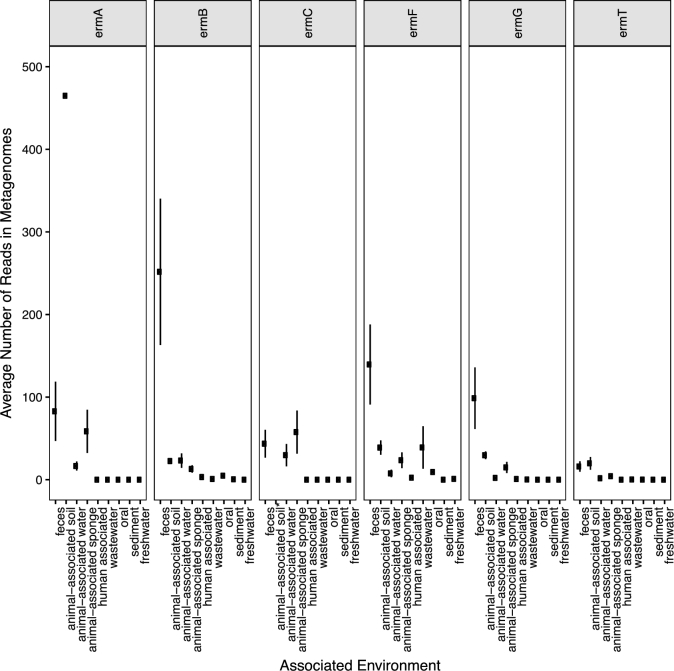
Average number of erm genes in metagenomes from various environments (see Table S1, Supporting Information). *For ermC gene, the average number of reads in animal-associated soil metagenomes was 1665 ± 659 reads.